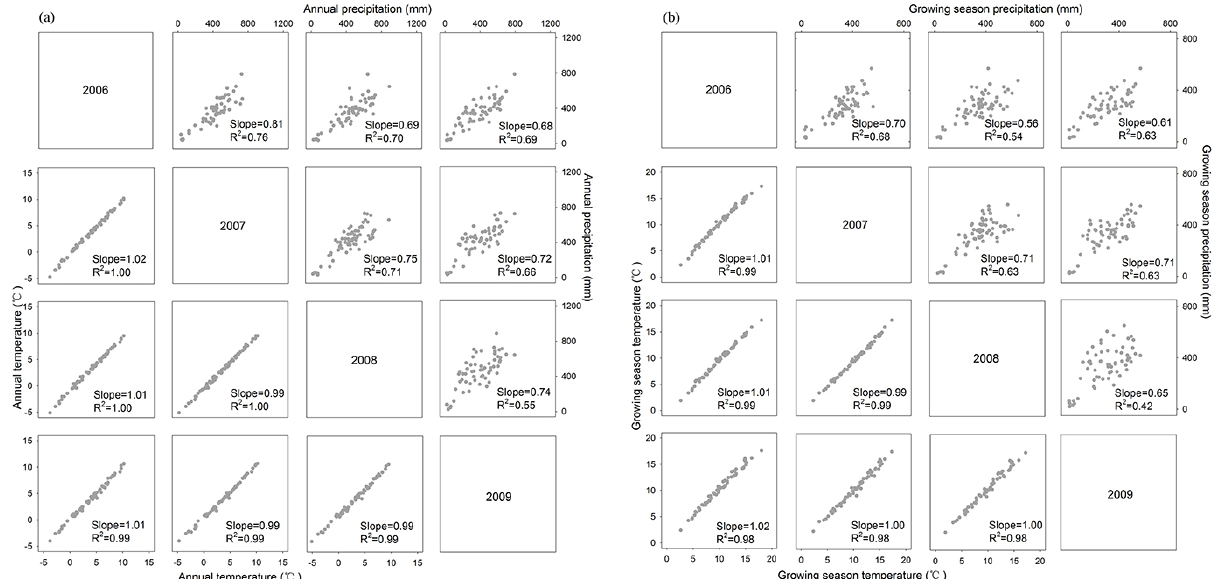
Fig. 4. The results from linear regressions of climate factors for (a) annual climate data and (b) growing season climate data between different years. All relationships are very significant ( P < 0 .